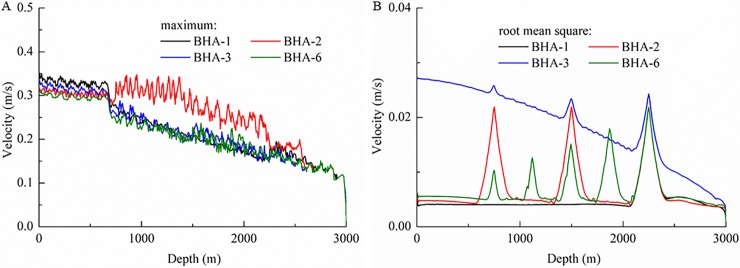
Velocity along the drill-string.(A) Maximum velocity. (B) Root mean square velocity. https://dx.doi.org/10.17504/protocols.io.ke6cthe.